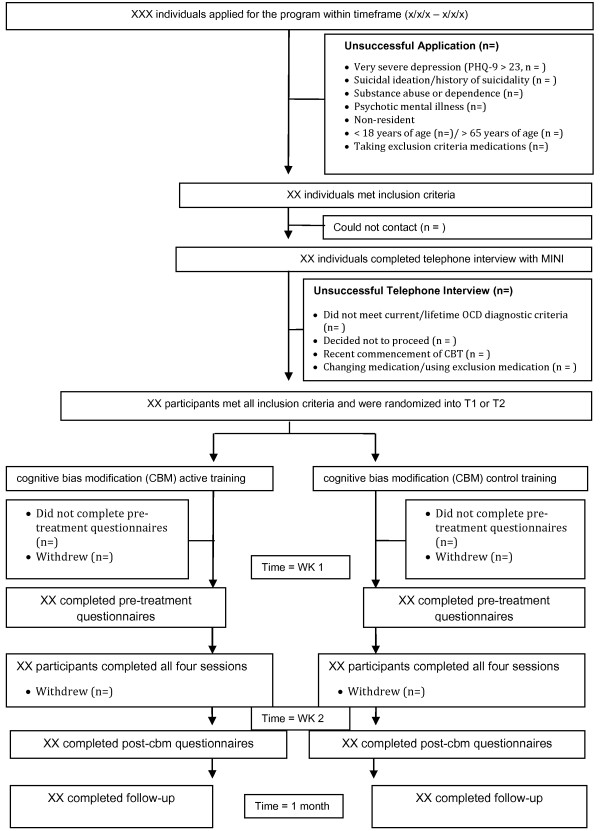
Study flow chart.